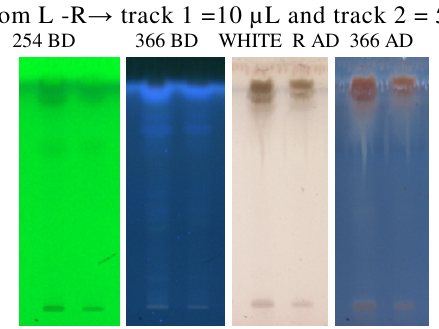
Figure 7. (Plate no 7) HPTLC of steroid